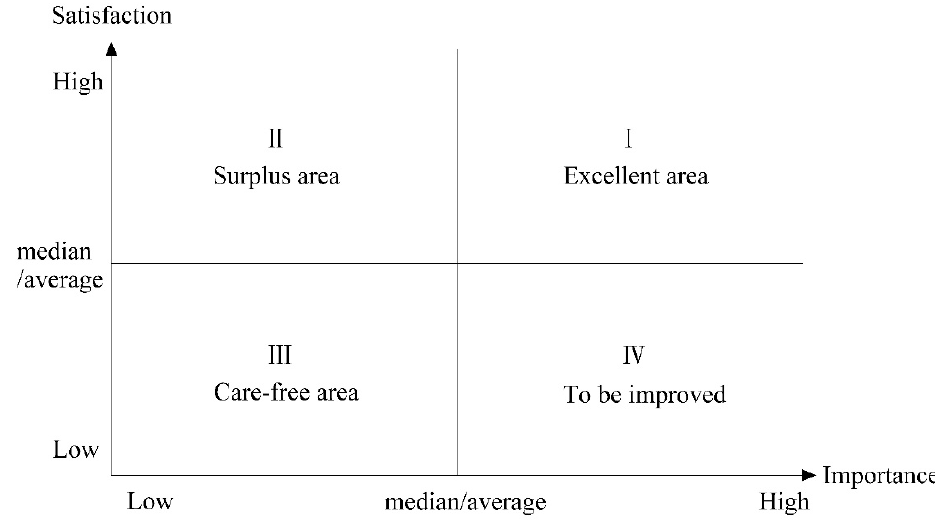
Figure 2. Importance–satisfaction model (IS model).